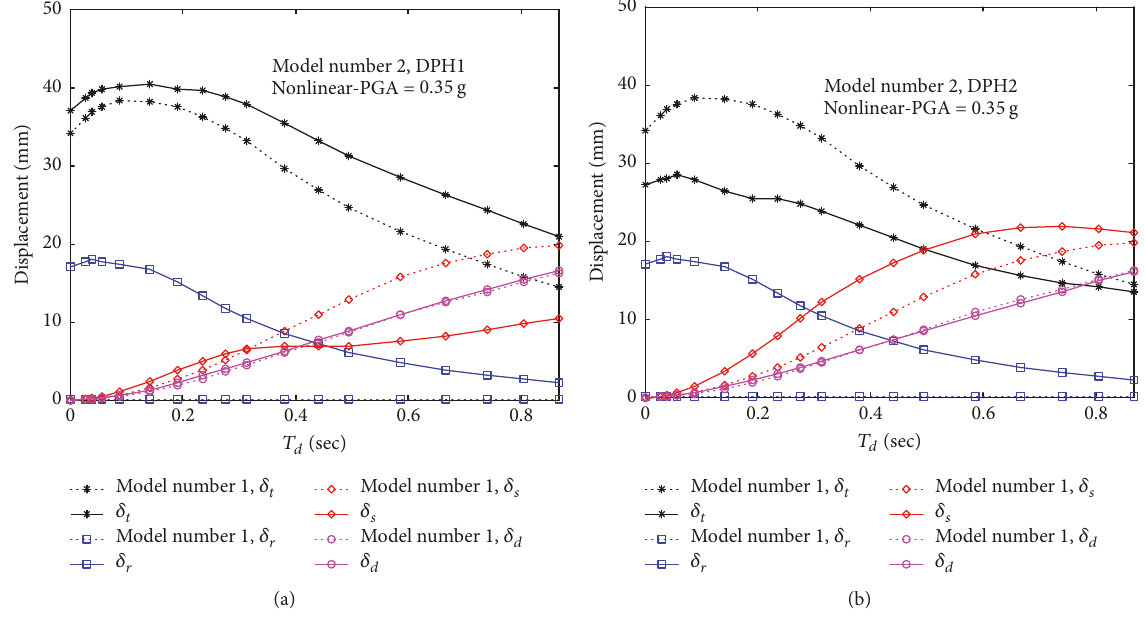
Figure 9: Deformation components of diaphragms for model 2 in DBE earthquakes: (a) DPH1 and (b) DPH2.